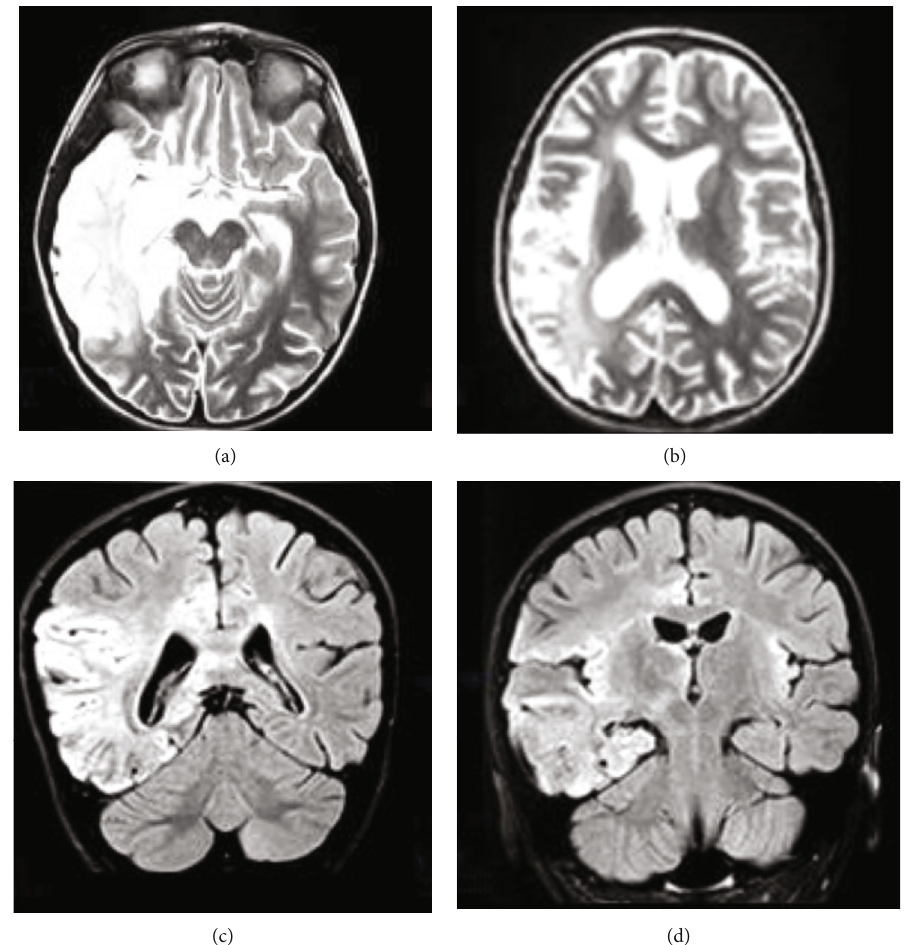
Figure 1: Brain magnetic resonance imaging from a patient with post-HSV-1 autoimmune encephalitis and NMDAR antibodies showed corticosubcortical hyperintensity in the right temporoparietal lobe on T2 weighted (a, b) and fl uid attenuation recovery (FLAIR) sequences (c,